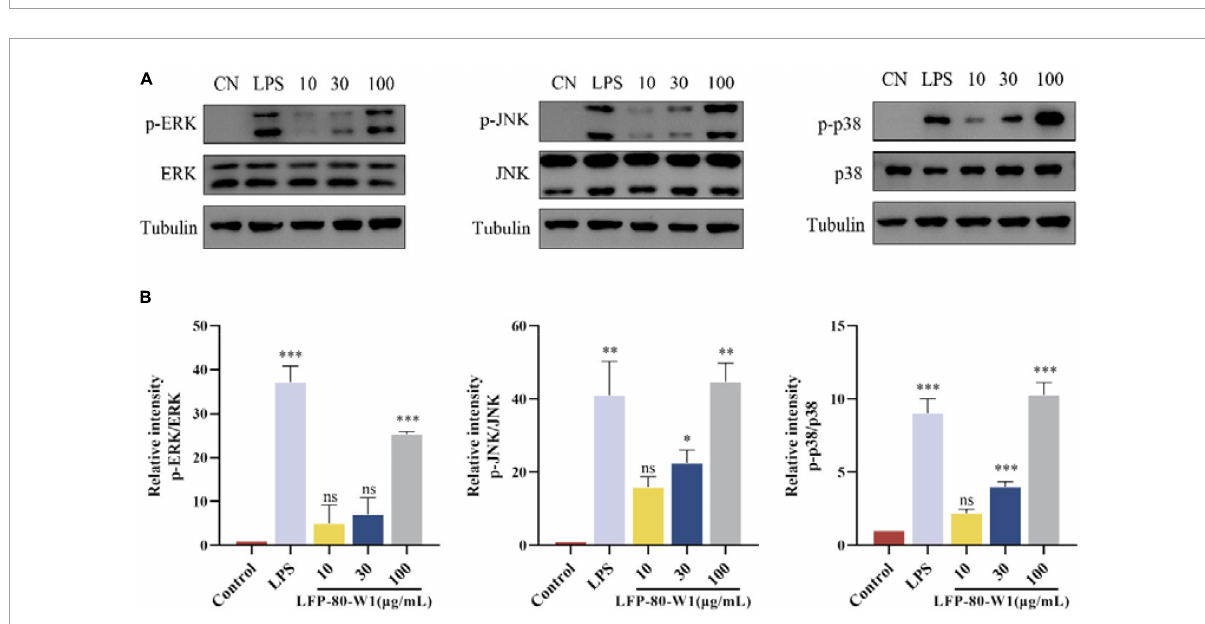
FIGURE7 Effects of LFP-80-W1 on the phosphorylation of MAPKs of RAW 264.7 cells. (A) Proteins were analyzed by western blot. (B) Histograms represent quantification of p38, ERK, and JNK expression levels, respectively. * p < 0.05, ** p < 0.01, and *** p < 0.001 compared with the untreated group.